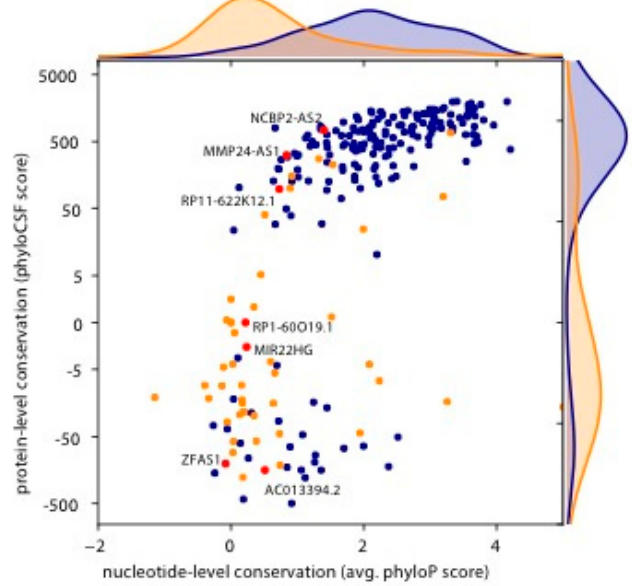
Figure 2. Conservation of nucleotide and amino acid sequence of the smORFs within lncRNAs identified upon viral infection. Plot of the conservation of the amino acid and nucleotide sequence of the candidate micropeptides encoded by lncRNAs. The phyloCSF score (y-axis) is a measure of amino acid conservation and the phyloP score (x-axis) indicates the nucleotide level conservation. The candidate smORFs (red dots) vary widely in amino acid and nucleotide level conservation. Blue dots indicate annotated ORFs, while orange dots indicate novel smORFs.